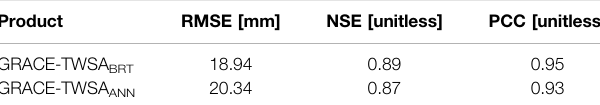
TABLE 1 | Summary statistics for the reconstructed GRACE – TWSA based on BRT and ANN during the validation stage using 20% of the whole time series. Product